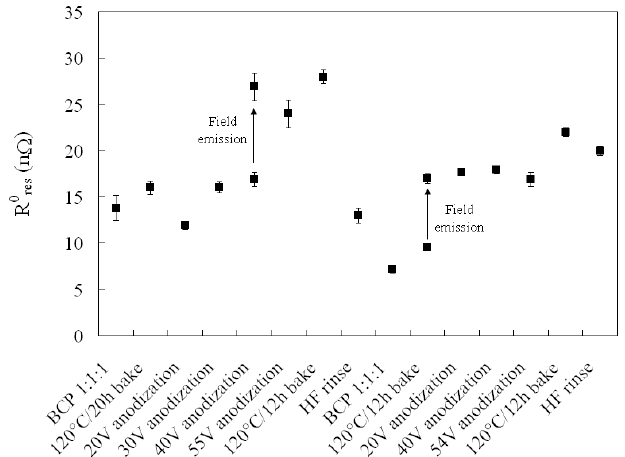
FIG. 4. Residual resistance as a function of surface treatment during the two series of anodization